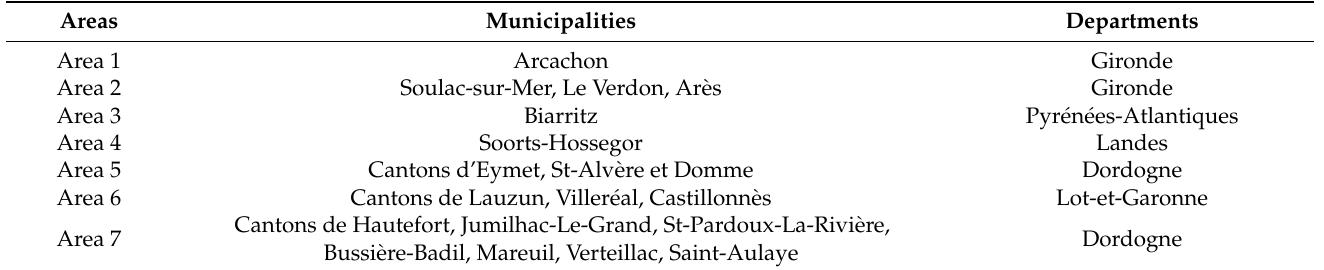
Table 1. Selected Areas in